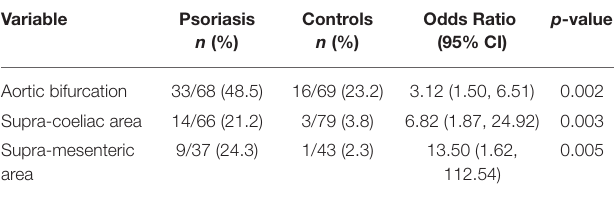
TABLE 2 | Abdominal aortic calcification in psoriasis patients vs. controls.